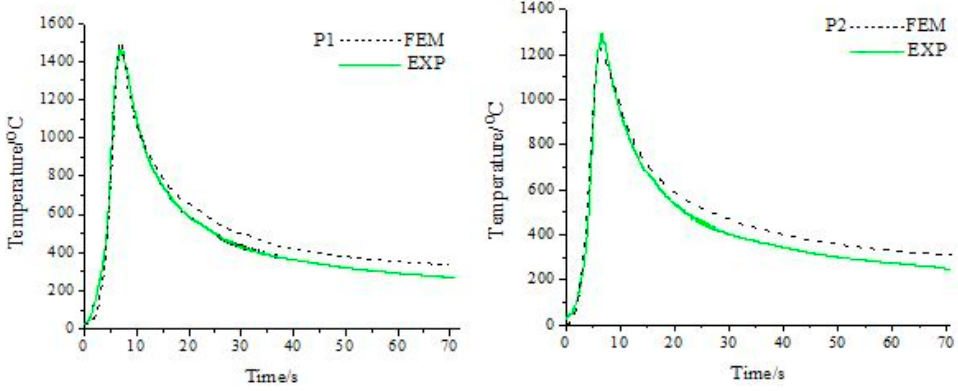
Figure 6. The comparisons between the simulated thermal cycles and experiments of points P1 and P2.